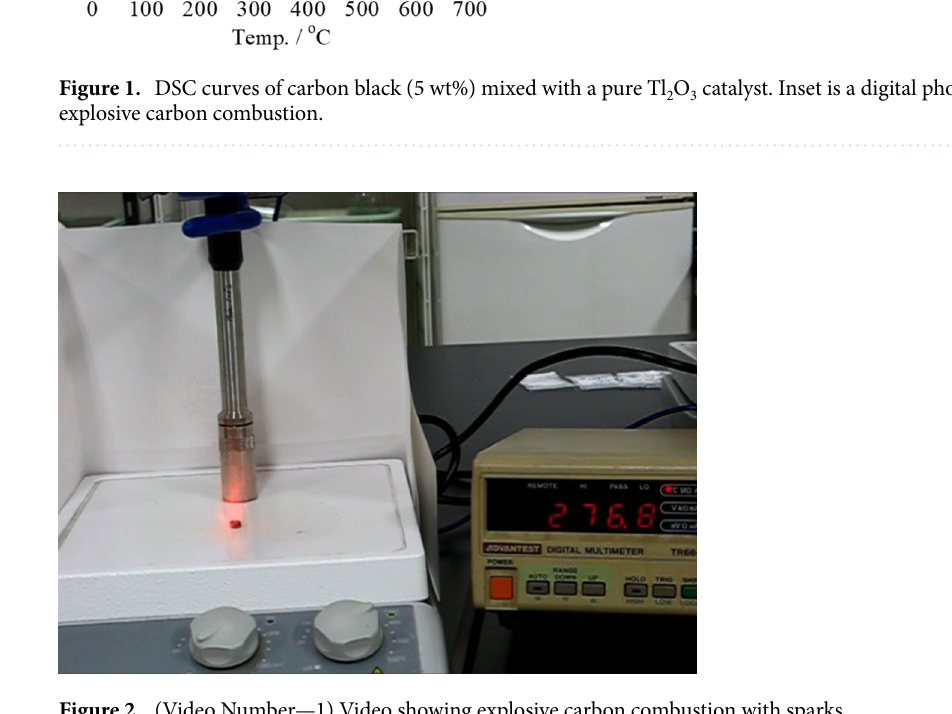
Figure 2. (Video Number—1) Video showing explosive carbon combustion with